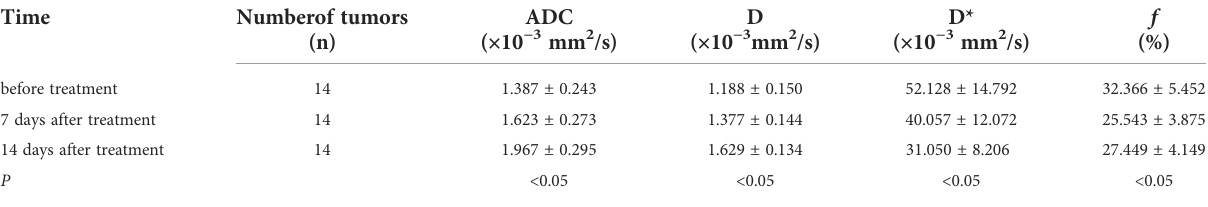
TABLE 1 Comparison of IVIM-related parameters in the experimental group before and 7 and 14 days after TAE combined with apatinib treatment (x ± s).